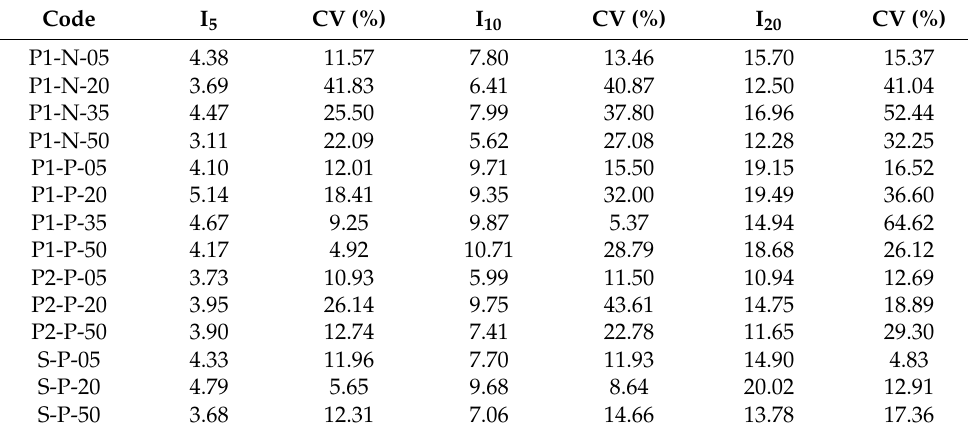
Table 8. Toughness indices of the analyzed